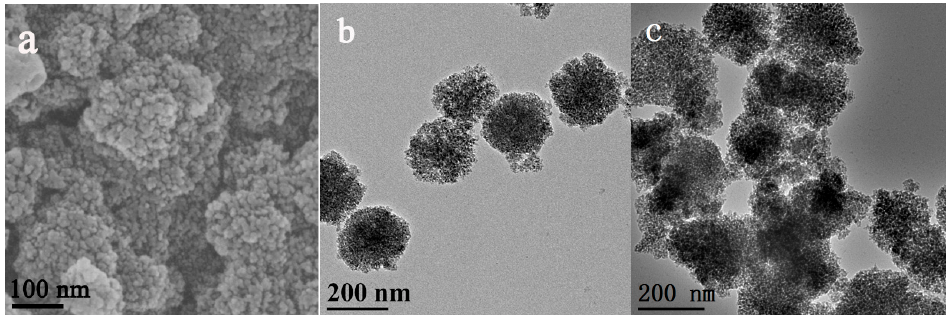
Figure 2. ( a ) SEM and ( b ) TEM images of Dop-TAMS and ( c ) TEM image of NHase@Dop-TAMS.